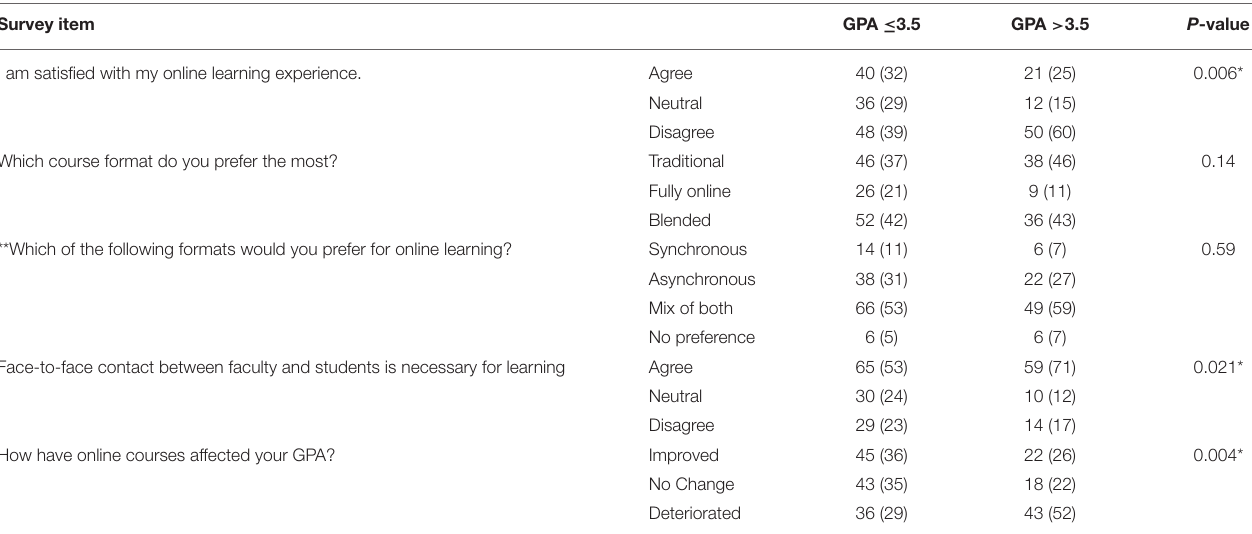
TABLE 3 | Preferences for online learning based on low ( N = 124) and high ( N = 83) GPA groups. Survey